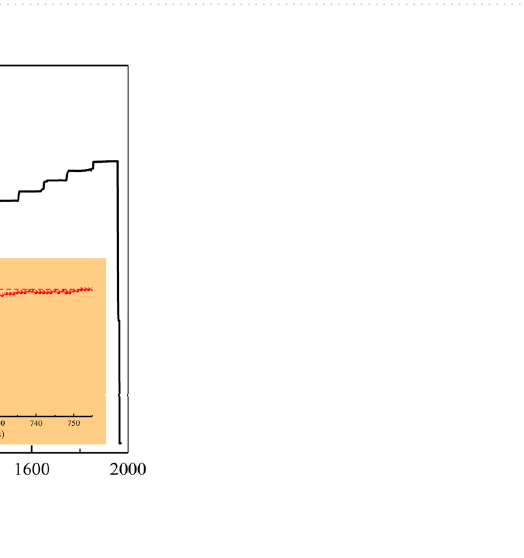
Figure 8. Relationship curves of effective stress, lateral pressure coefficient of in-situ stress and critical gas pressure.